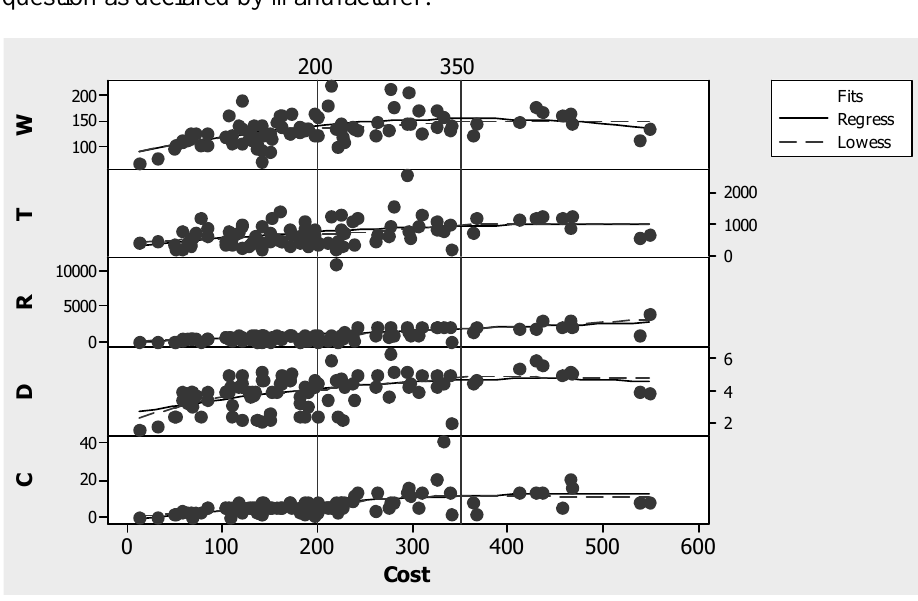
Figure 6 – Matrix plot of W; T; R; D; C vs